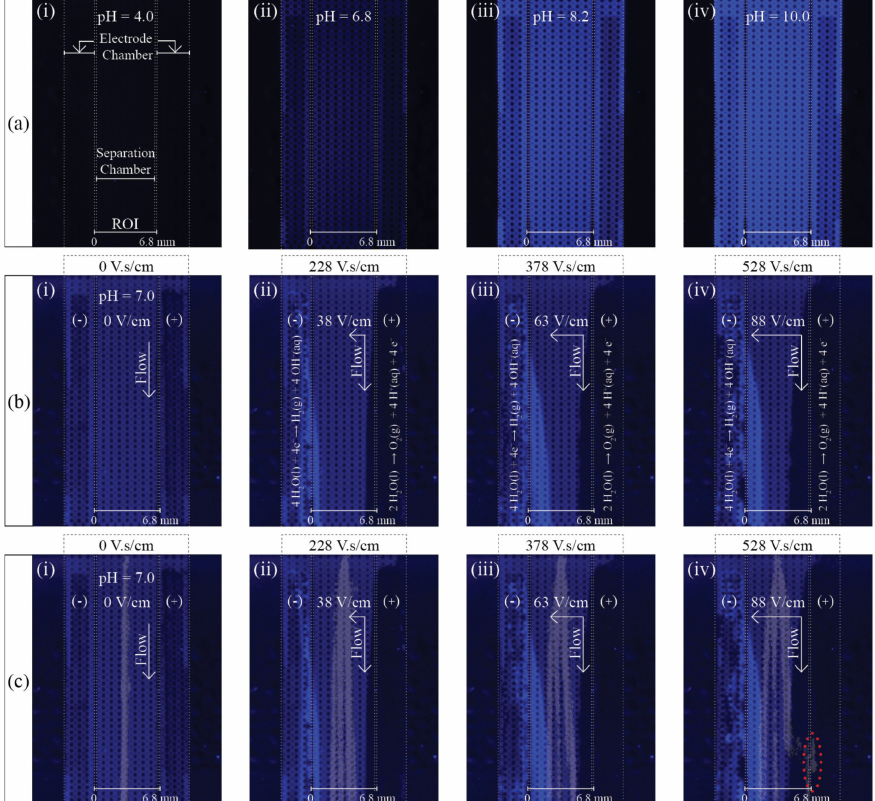
Figure 8. Spatial-temporal characterization of the microfluidic chamber local pH using fluorescence imaging of 4MU solution (0.25 mM 4MU, 0.2% of HPMC in 10 mM HEPES, pH 7.0). ( a ) Fluorescence images of 4MU solution at different pH. ( b ) Fluorescence images of 4MU solution in separation conditions at increasing separation power and constant flow velocity of 4.1 mm/s. ( c ) Superposed fluorescence data from 4MU solution in separation conditions, depicted in Figure 8b, and the sample mixture separation, depicted in Figure 4.